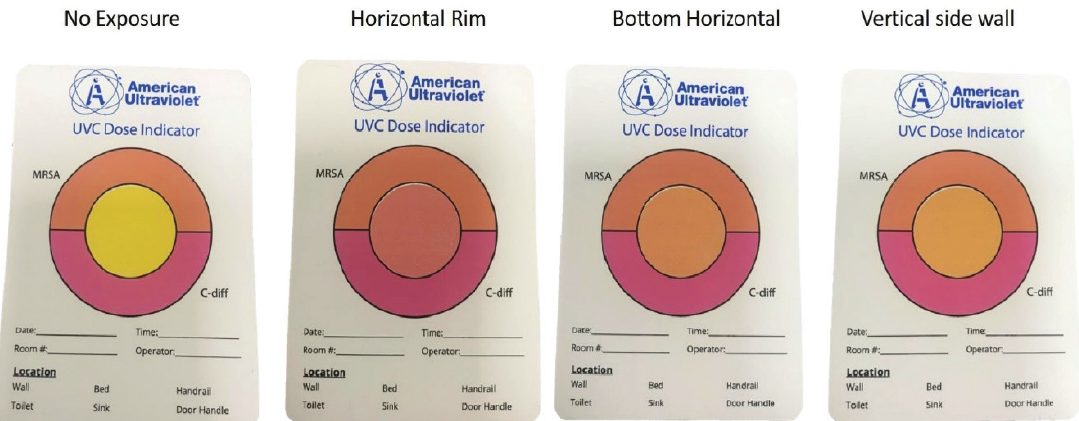
Figure 3 . Pictures showing colorimetric indicators (UVC Dose Indicator, American Ultraviolet) placed adjacent to organism inoculation sites shown in Figure 1 during 30-second UV-C cycles. The color of the central circle indicates the level of UV-C exposure: yellow, no exposure; orange, dose sufficient to inacti- vate methicillin-resistant Staphylococcus aureus (MRSA); pink, dose sufficient to inactivate Clostridioides difficile